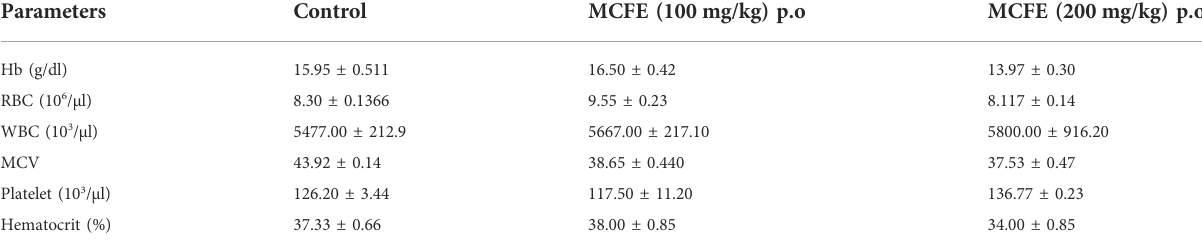
TABLE 6 Measurement of blood parameters on chronic administration of